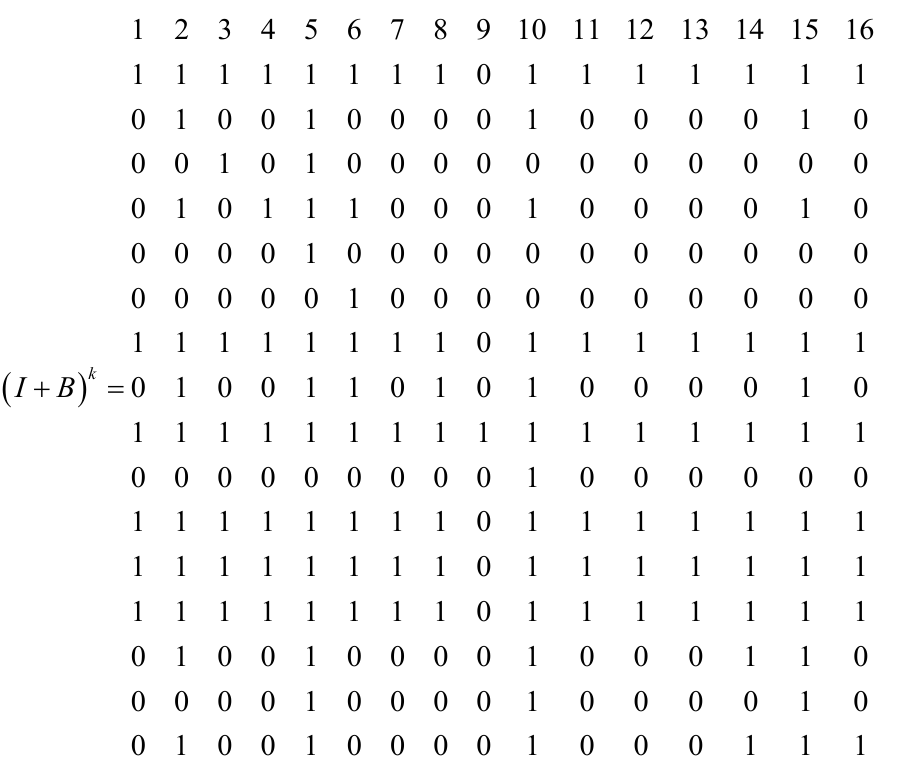
Figure 2. Matrix of reachability fragment on C Sharp